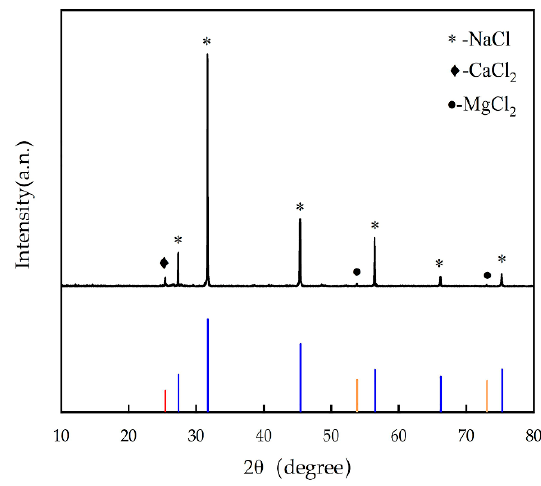
Figure 9. X-ray diffraction pattern of crystal in the salt drying